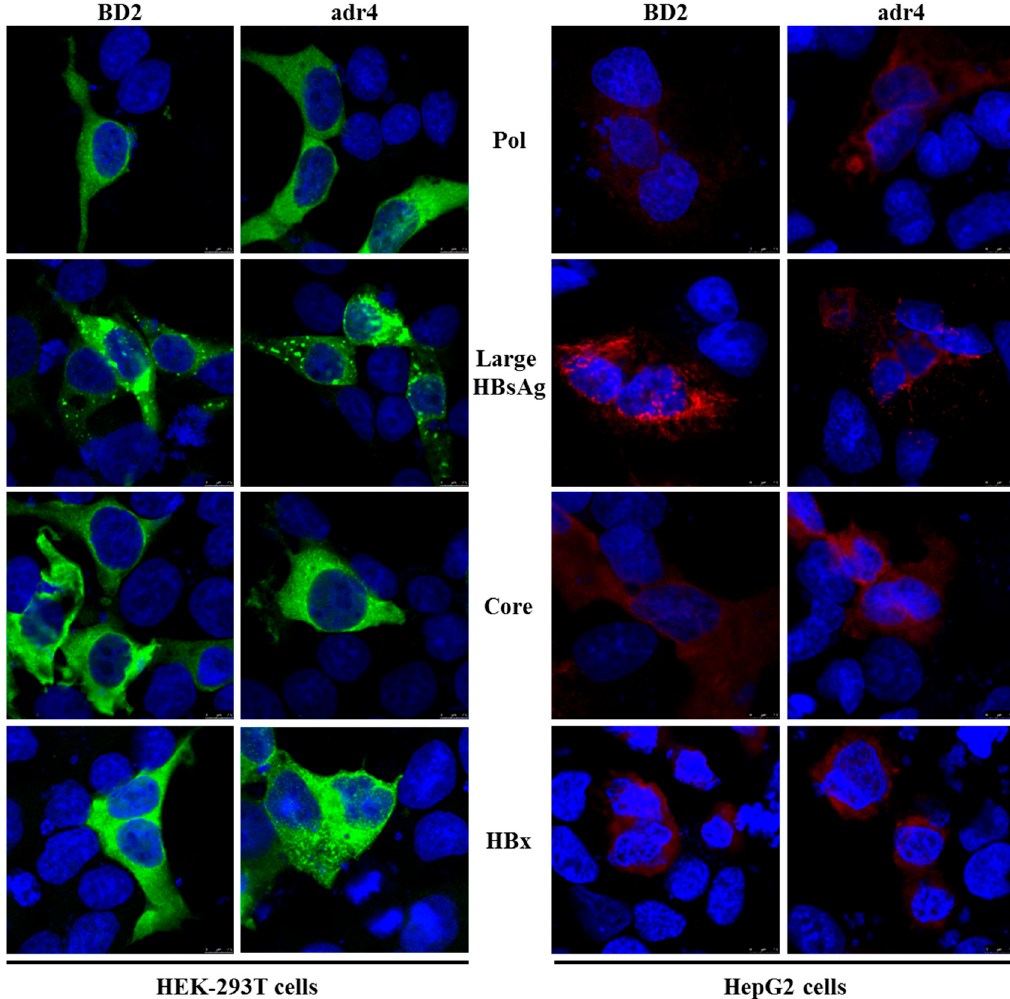
Figure 3. Expression analysis of HBV proteins by immunofluorescence analysis. HEK-293T and HepG2 cells were transfected with pCMV-Myc carrying specific HBV genes. Cells were fixed, permeabilized, and stained with Myc tag Ab at 48 h after transfection, followed by an Alexa Fluor 488-conjugated anti-mouse IgG (Green) for HEK-293T cells and Alexa Fluor 546-conjugated anti-mouse IgG (Red) for HepG2 cells. The cell nuclei were stained with DAPI (blue). The experiment was performed at least three independent times, and one representative data set was presented.